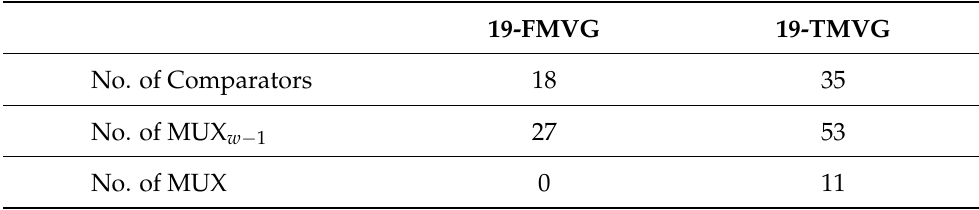
Table 4. Components required for the minimum finders of d c = 19 inputs of bit-width ( w − 1 )